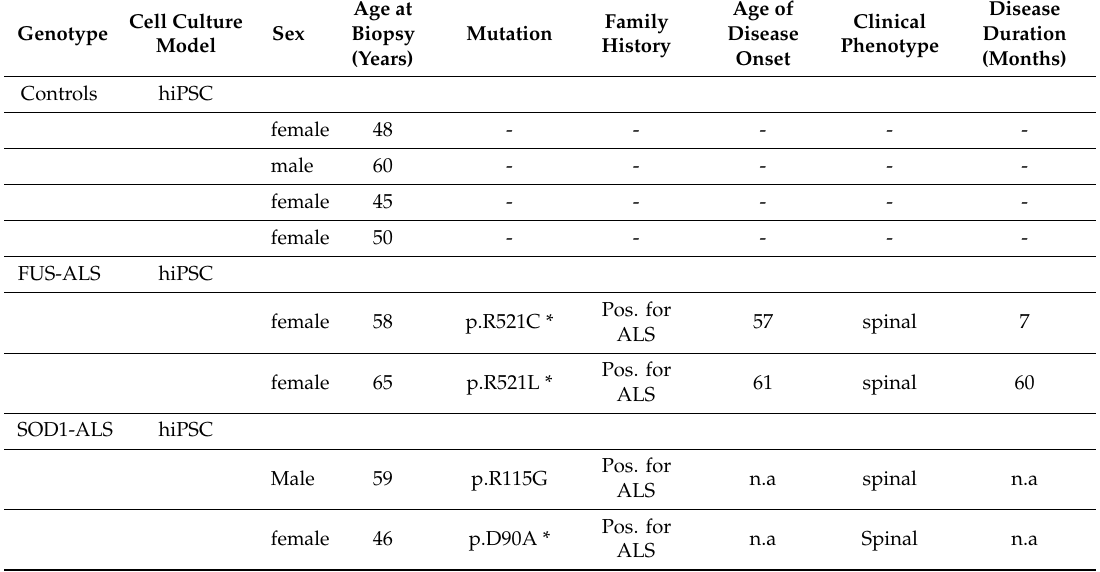
Table 2. Patient / proband